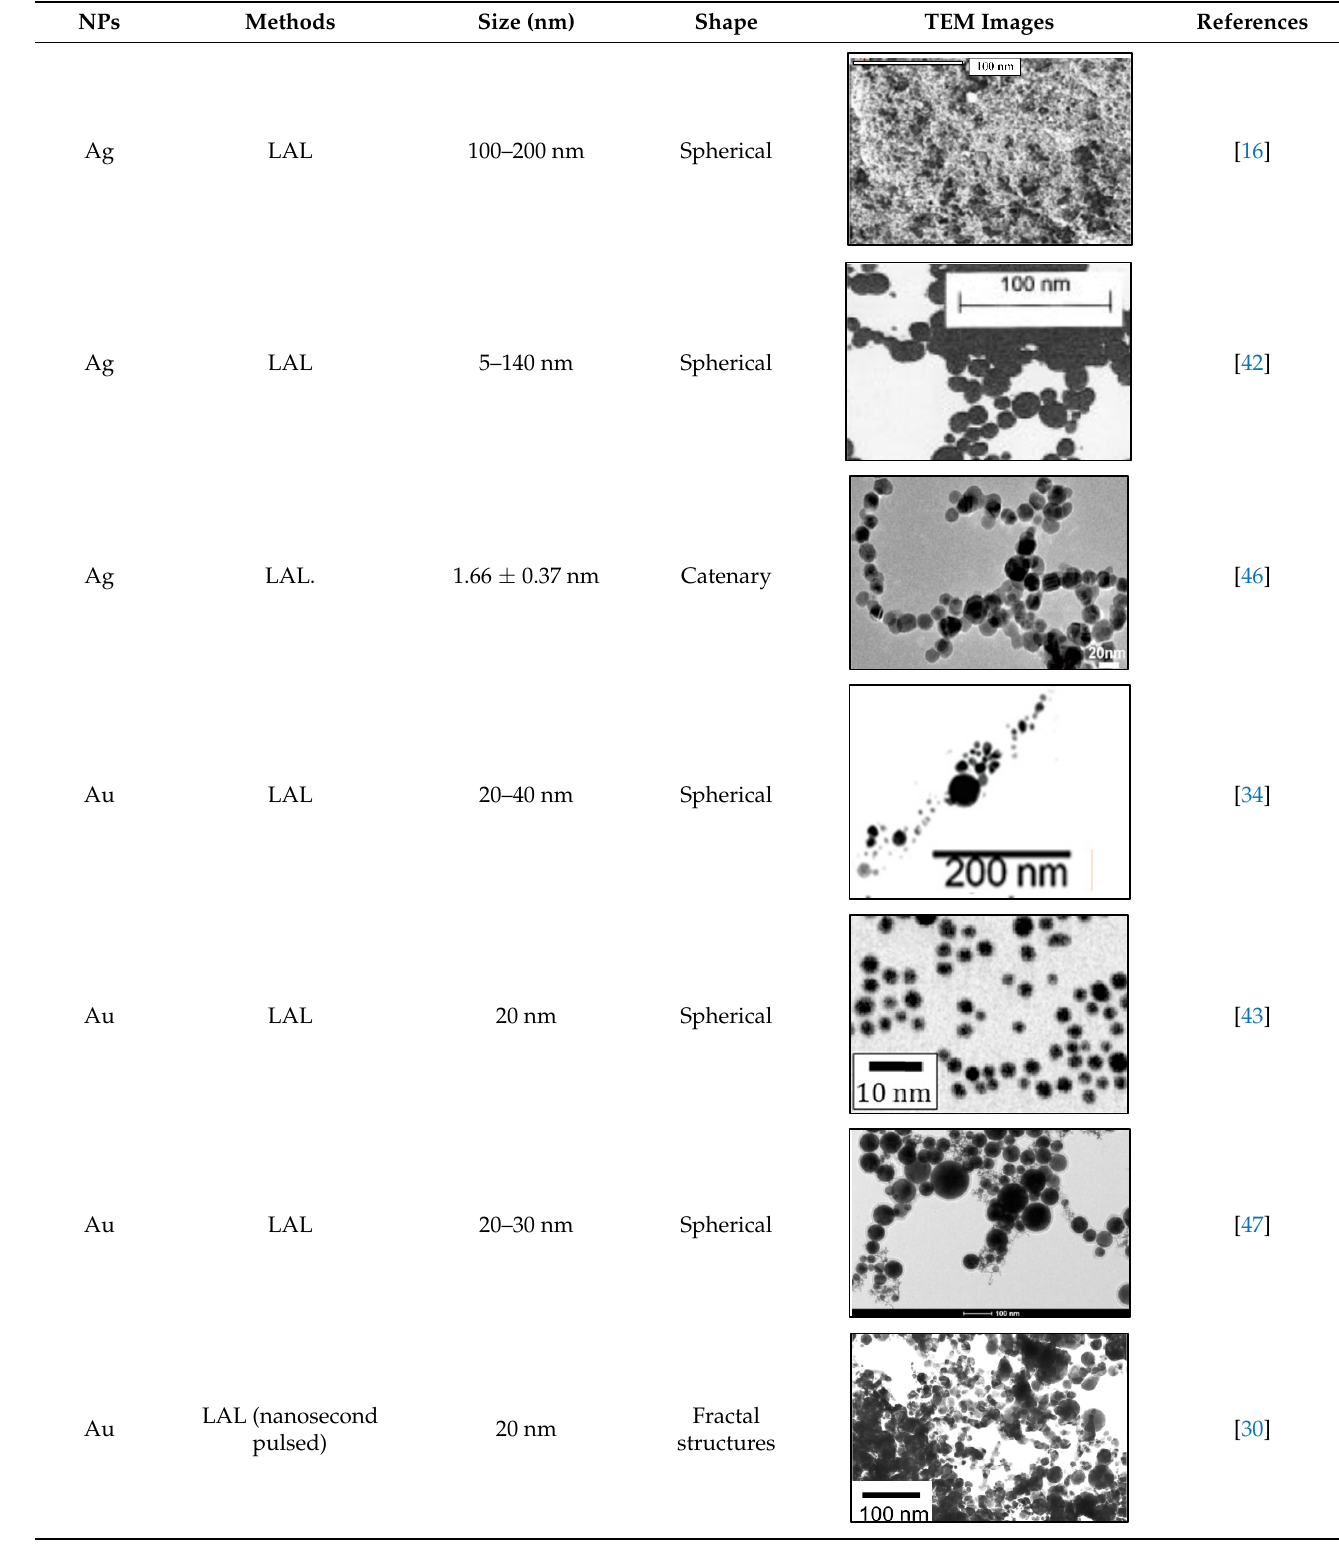
Table 1. Comparison of the size and shape of NPs in LAL.